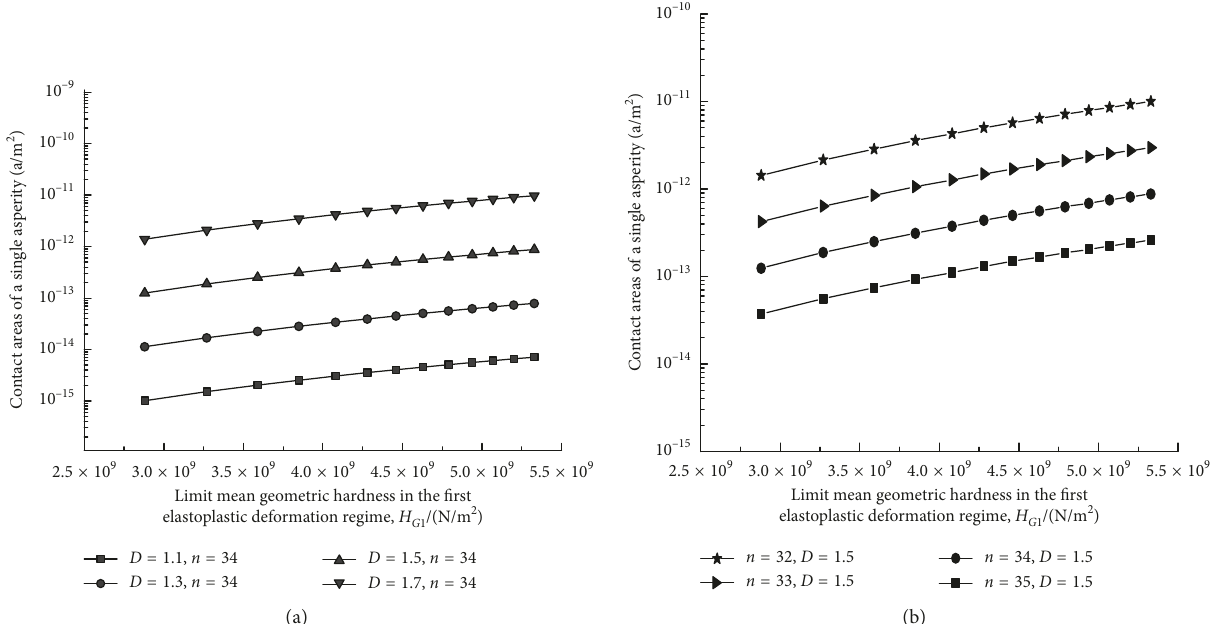
Figure 6: The relationship between limit mean geometric hardness and contact for single asperity during the first elastoplastic deformation stage. (a) n � 34, 1 . 1 ≤ D ≤ 1 . 7. (b) D � 1 . 5, 32 ≤ n ≤ 35.